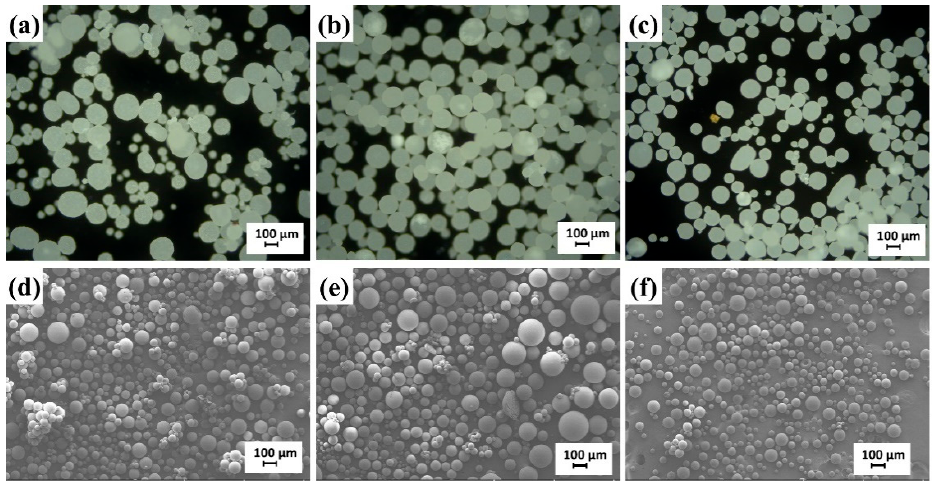
Figure 4. OM and SEM images of the microcapsules with different GA dosages: ( a ) 5 wt%, ( b ) 7.5 wt%, ( c ) 12.5 wt%, ( d ) 5 wt%, ( e ) 7.5 wt%, ( f ) 12.5 wt%.